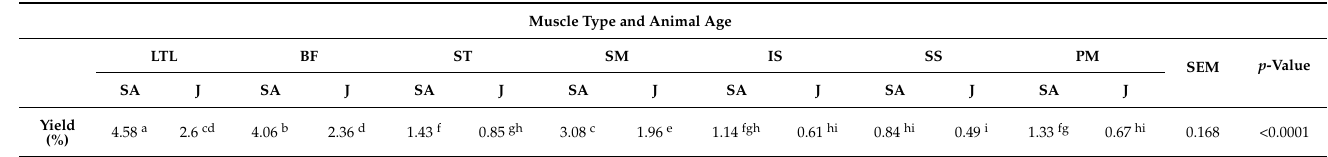
Table 3. Effect of age and muscle type interaction on the individual muscle yields (as a percentage of the cold side weight) of farmed common eland